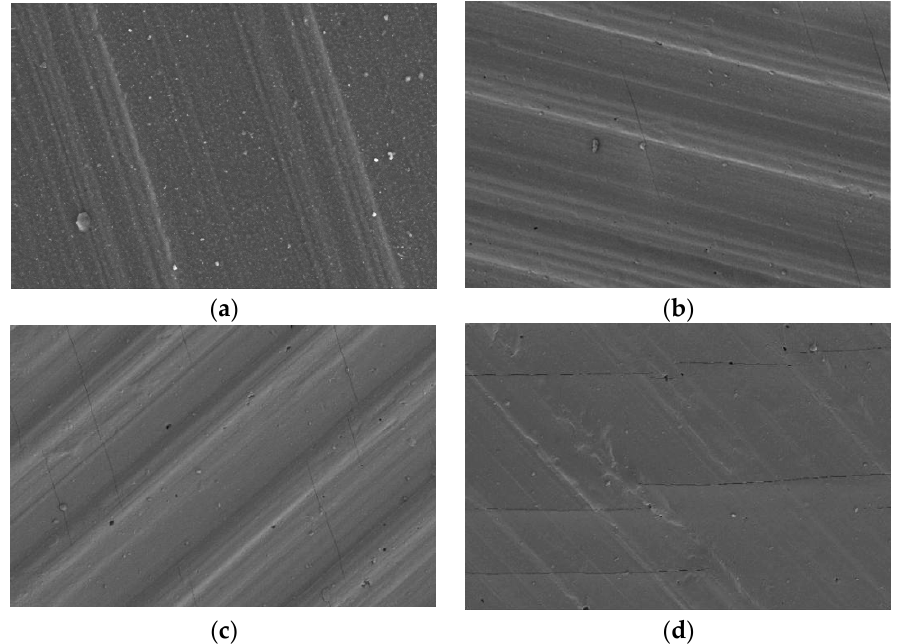
Figure 10. Surface morphology changes with low temperature freezing time. ( a ) Freezing 0 h, ( b ) Freezing 300 h, ( c ) Freezing 750 h, ( d ) Freezing 1050 h. ( b ) Freezing 300 h, ( c ) Freezing 750 h, ( d ) Freezing 1050